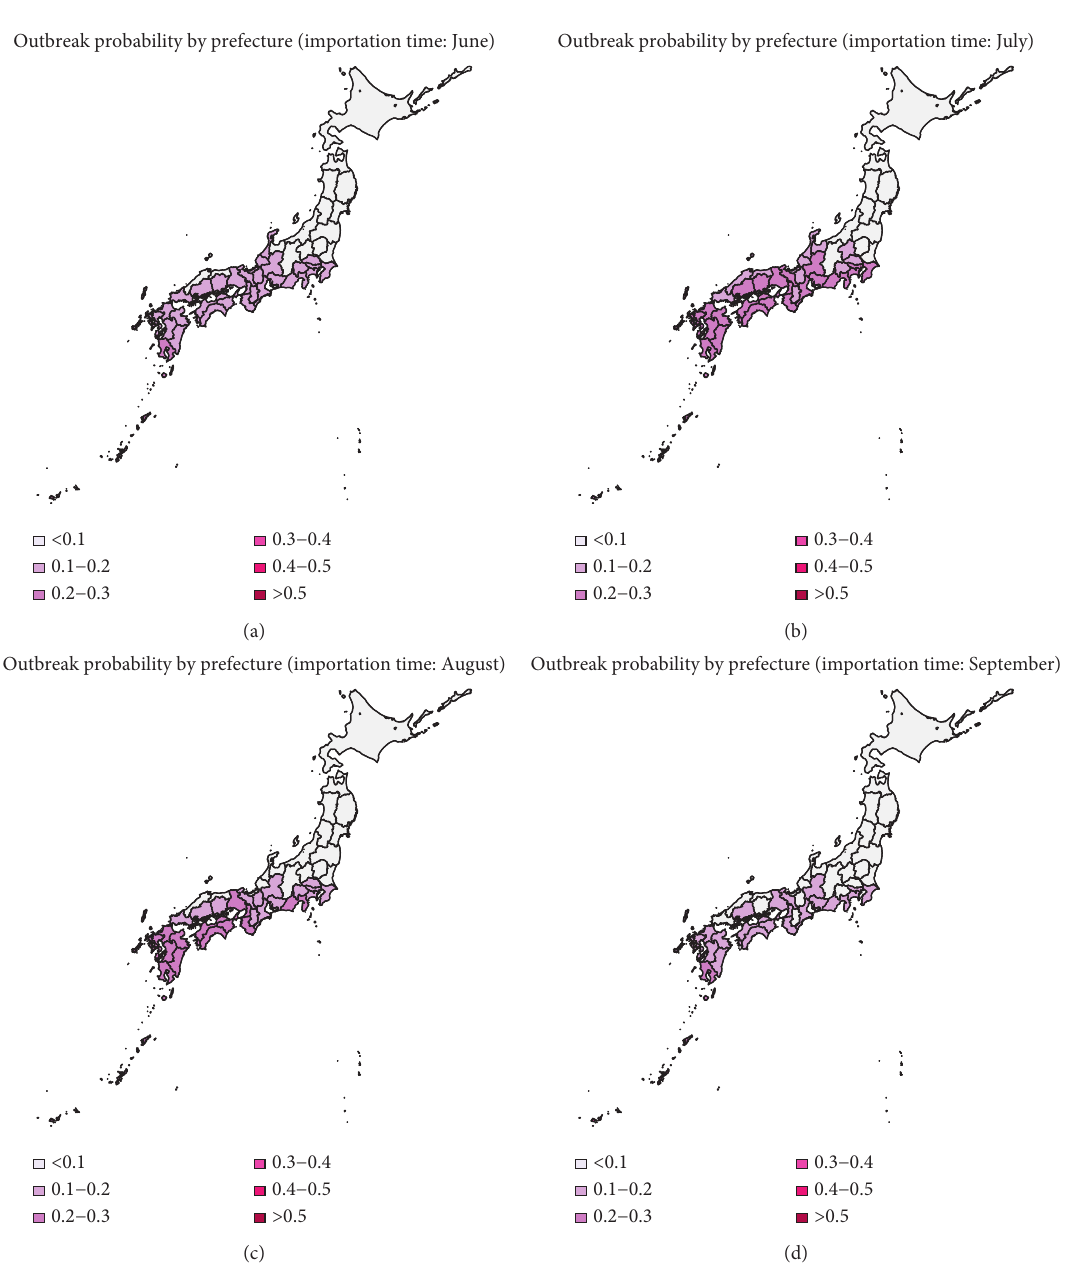
Figure 7: Heat map of the mean probability of outbreak in November (2013–2016), when the infectious individual is imported in June, July, August, and September; k �